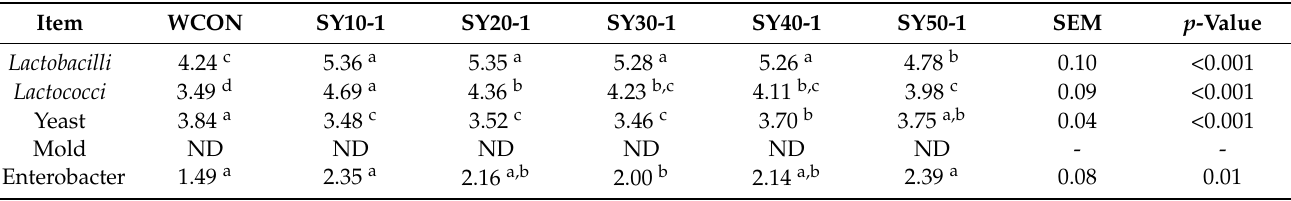
Table 10. Microbiological analysis results of corn silages, log10 CFU/g.